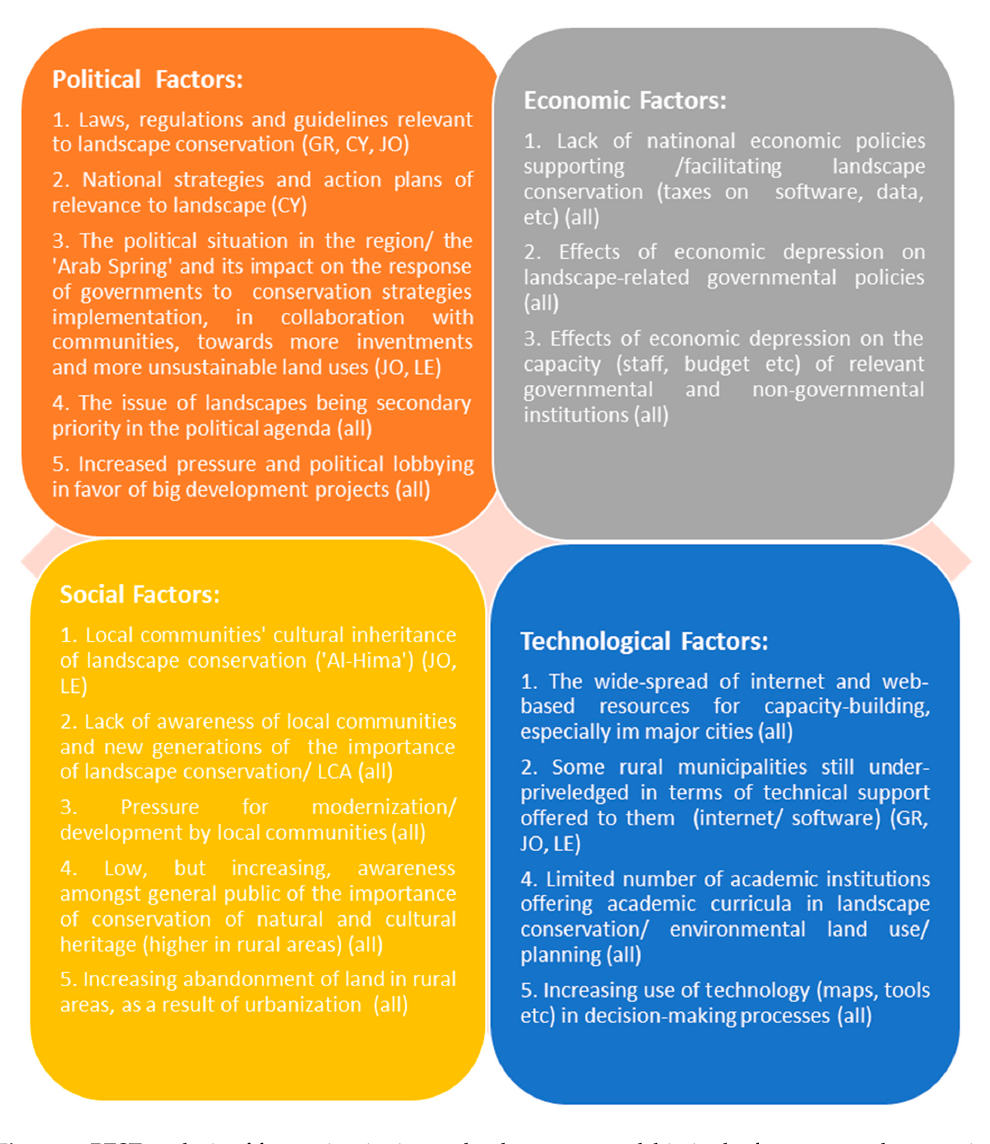
Figure 9. PEST analysis of factors impinging on landscape stewardship in the four case study countries (Cyprus, Greece, Jordan, Lebanon). Source: MedScapes final report (http://www.enpi-medscapes.org/images/Deliverable/MEDSCAPES REPORT ON STAKEHOLDERS NEEDS KNOWLEDGE.pdf).